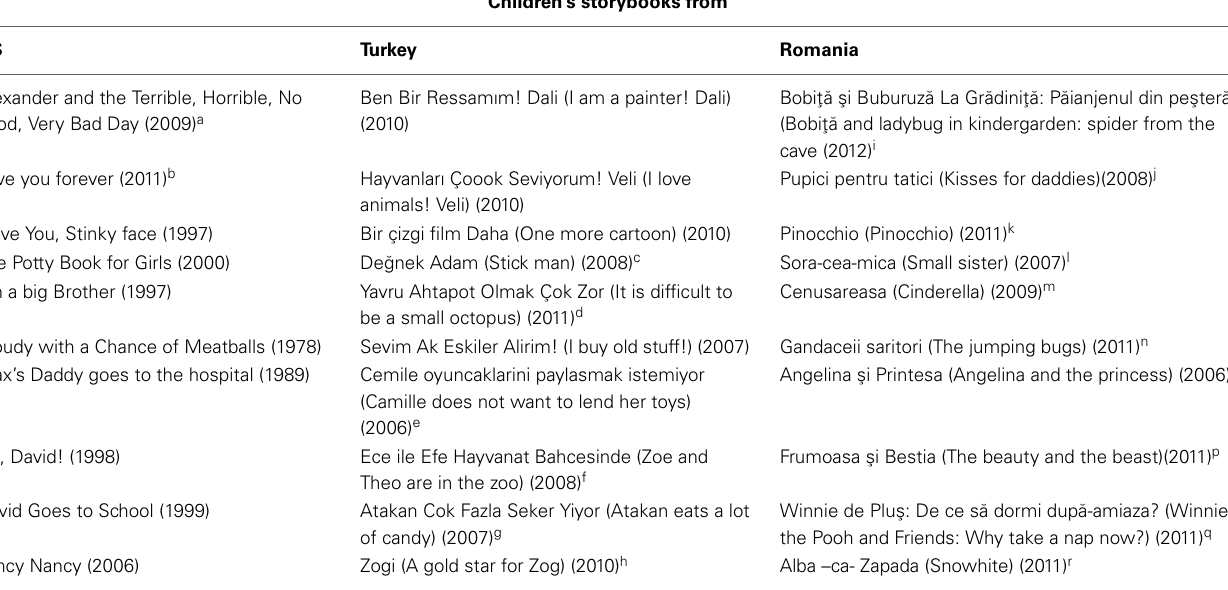
Table 1 | Book titles of the selected